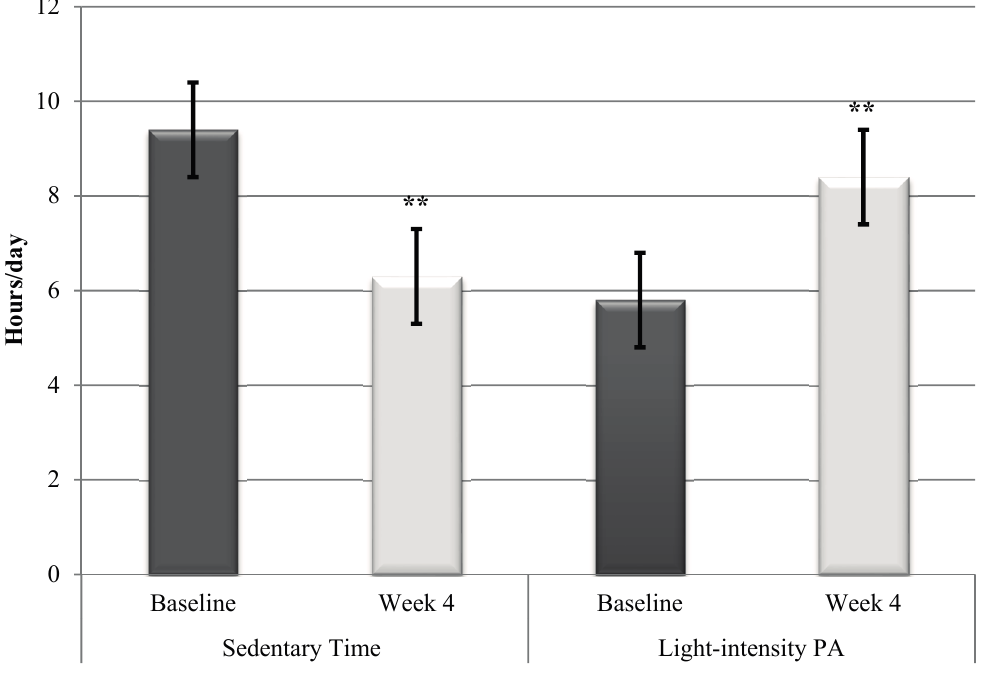
Figure 1. Decrease in sedentary time and increase in light intensity physical activity from baseline to week 4 (data from Gruve monitor). ** p <